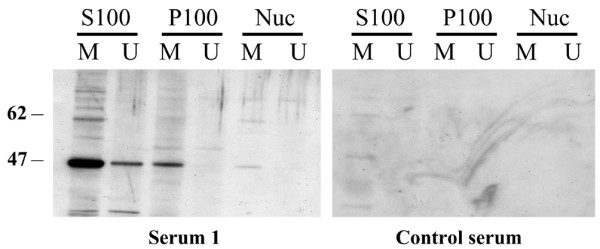
Intracellular expression of immunogenic citrullinated 47 kDa protein. Presence of citrullinated 47 kDa protein reactive with rheumatoid arthritis serum 1 in different subcellular fractions of undifferentiated HL60s (U) and HL60 monocytes (M) (S100, cytosolic; P100, membrane; Nuc, nuclear) showing enrichment in the S100 (cytosolic) fraction.